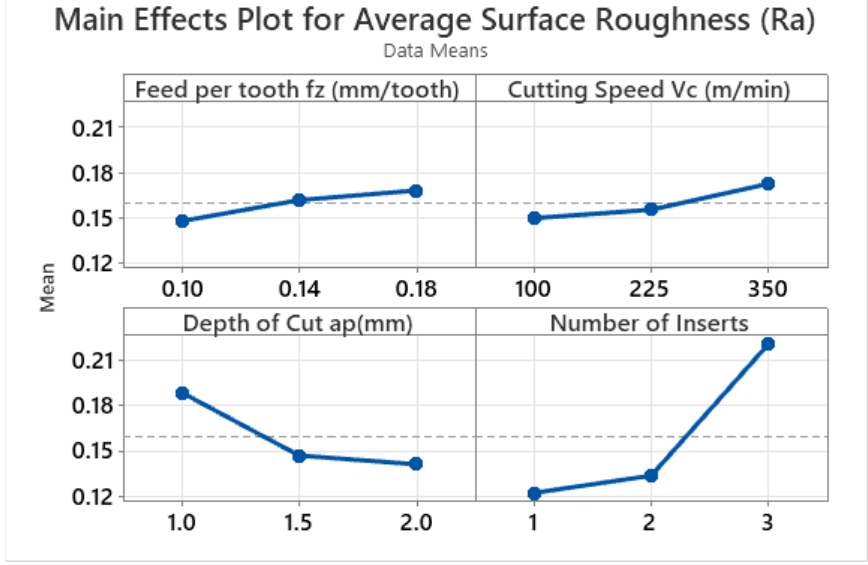
Figure 2. Main effect plots for average surface roughness (µm). Table 5. ANOVA results for average surface